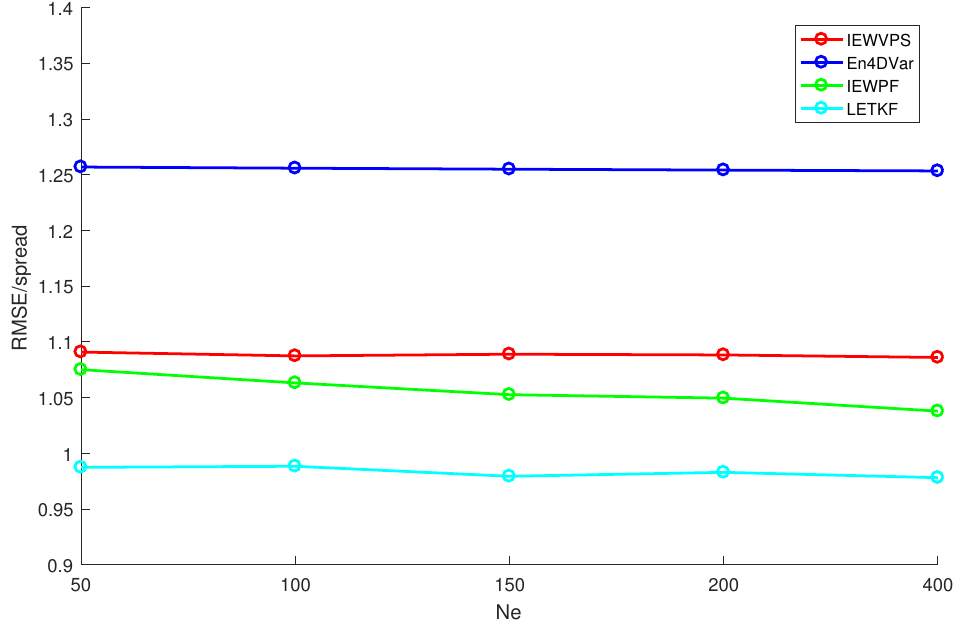
Figure 7. Mean RMSE/spread as a function of ensemble size. Red for the IEWVPS experiments; Blue for the En4DVar experiments; Green for the IEWPF experiments; Cyan for the LETKF experiments. The model dimension N x =